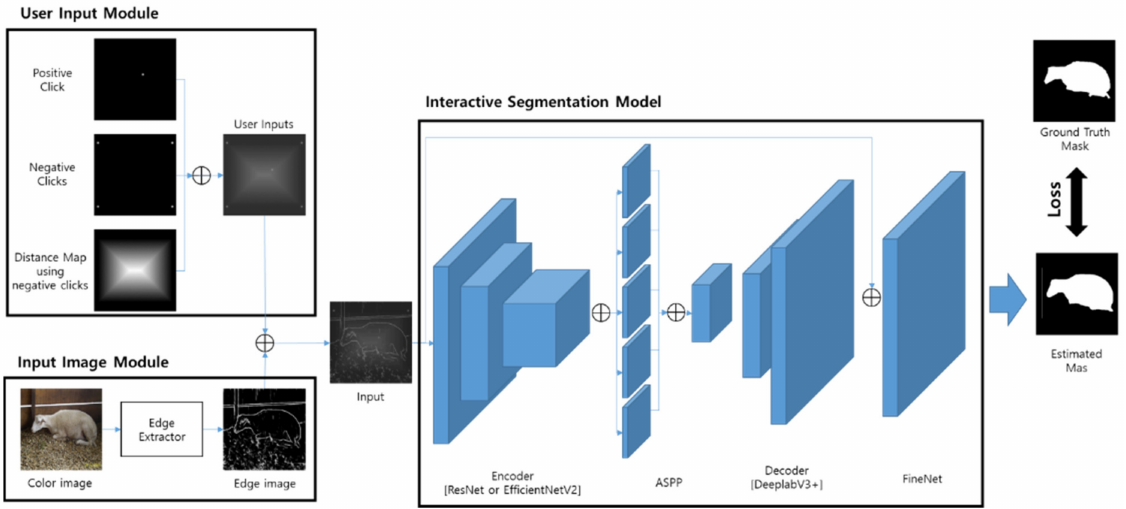
Figure 1. The diagram of the proposed model